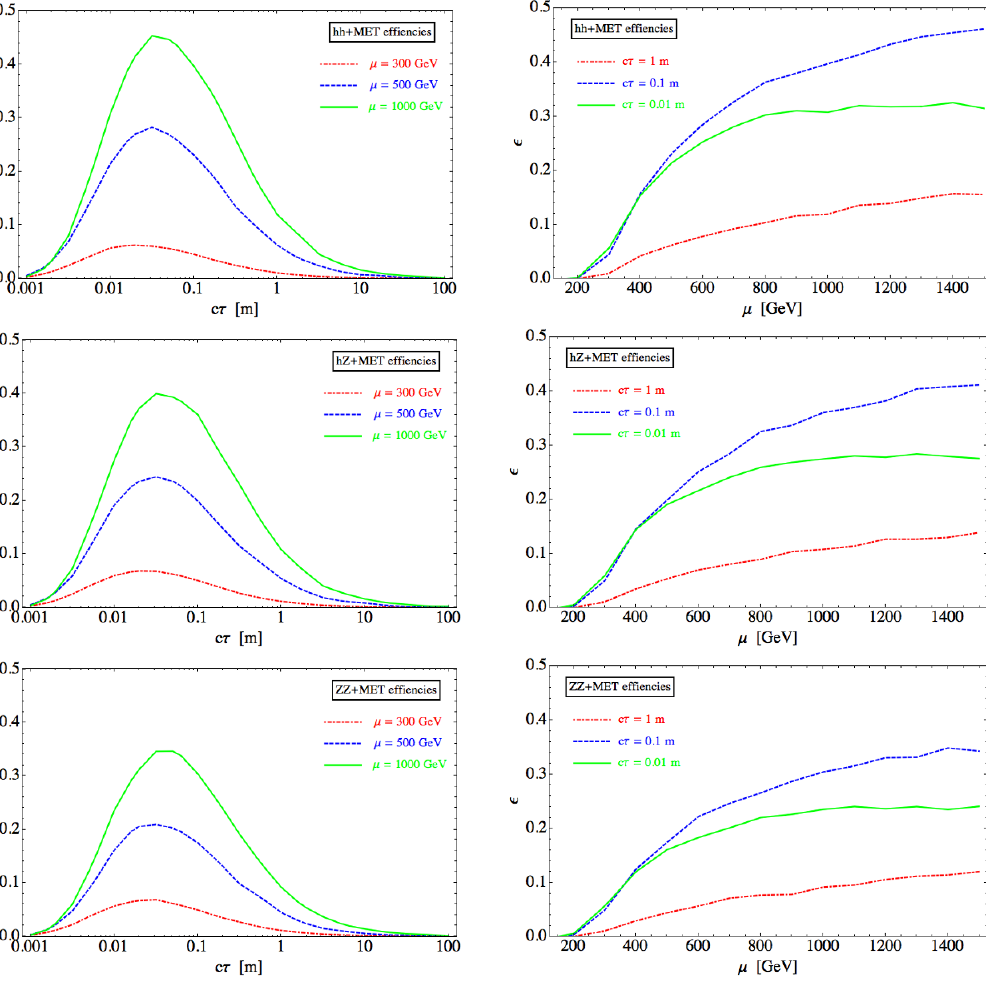
Figure 14 . E(cid:14)ciencies for the simpli(cid:12)ed (cid:12)nal states with hh + E / e(cid:14)ciencies as a function of c(cid:28) for m (cid:31) of the mass m (cid:31)